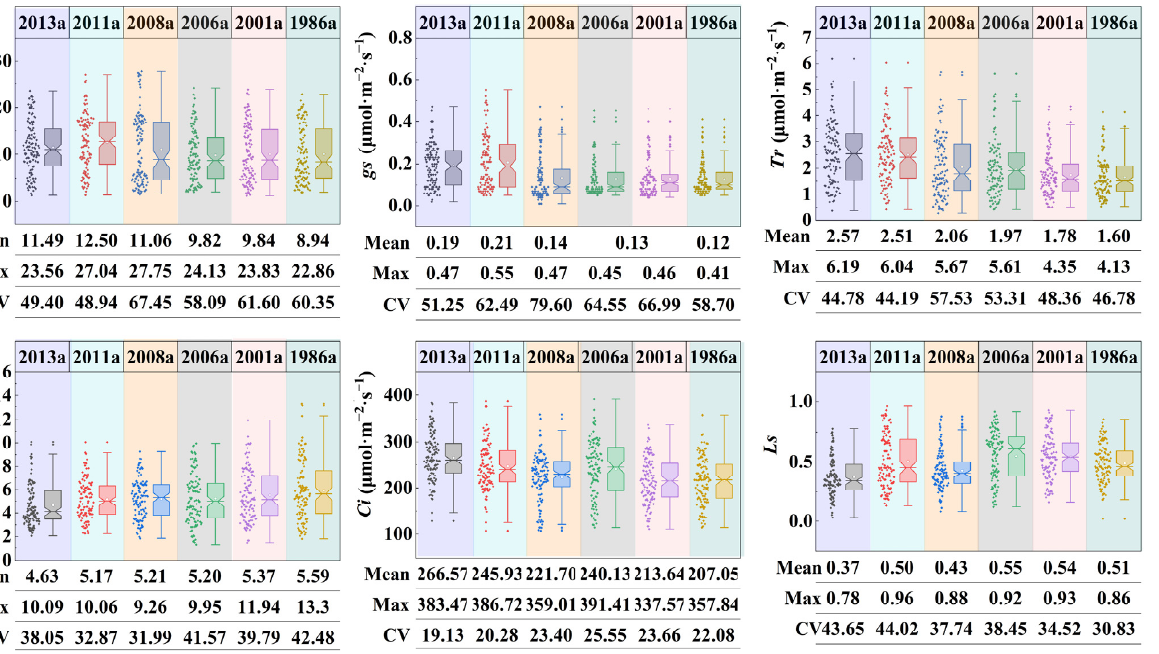
Figure 2. Characteristics of photosynthetic parameters of the plantation. Table 3. Correlation between photosynthetic parameters and afforestation years.